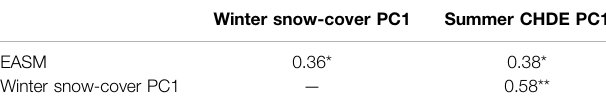
TABLE 2 | Correlation coef fi cients between the EASM index and the PC1s of winter snow cover and summer CHDEs for 1981 – 2020. Winter snow-cover